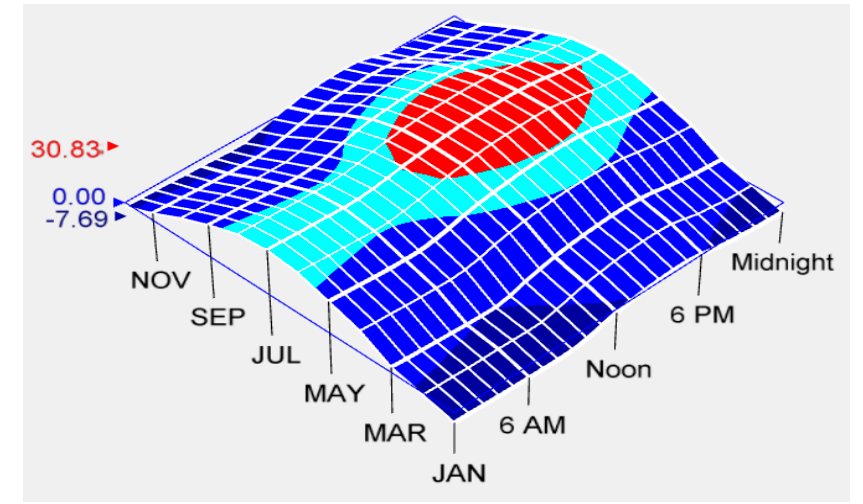
Figure 3. Typical Meteorological Year Dry Bulb Temperature in Baoding Area.